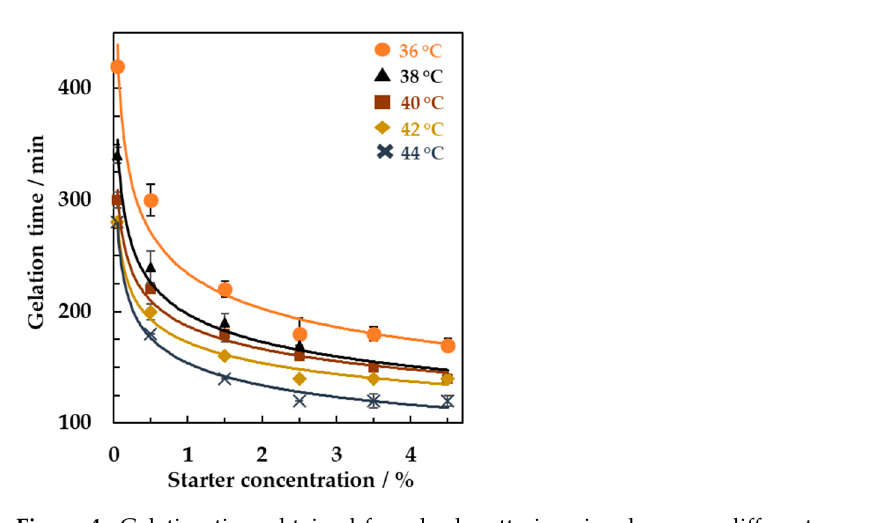
Figure 4. Gelation time obtained from backscattering signals versus different concentrations of yogurt starter as a function of the incubation temperature.